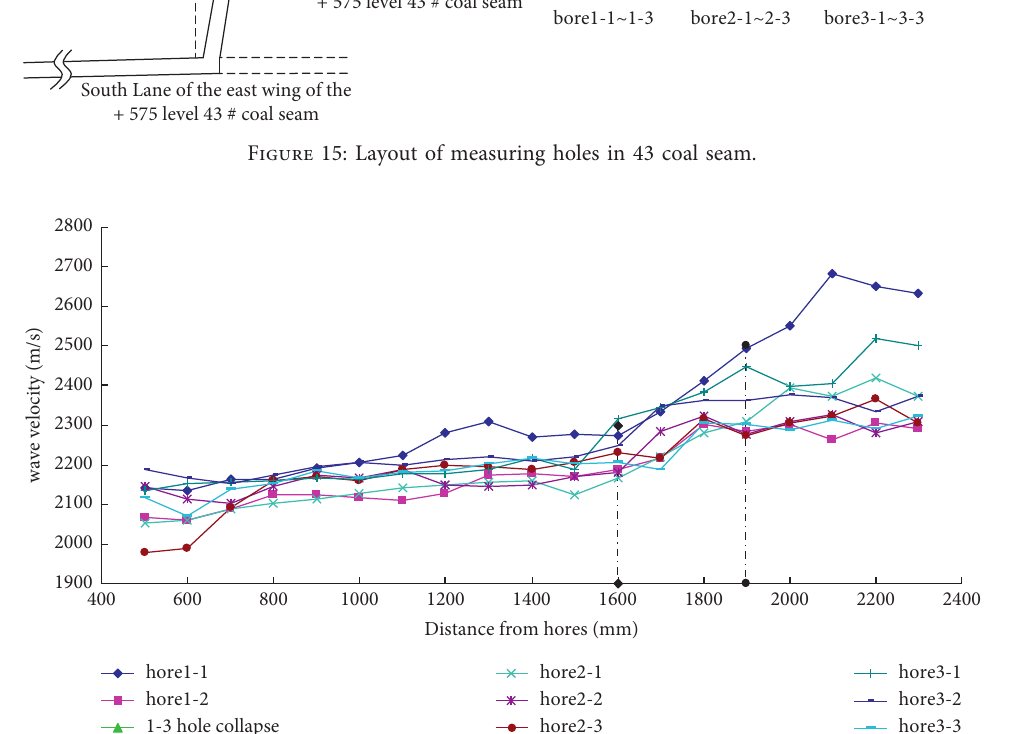
Figure 16: Test curve of surrounding rock loose zone in north roadway of 43 # coal seam in the east wing of +575 level.